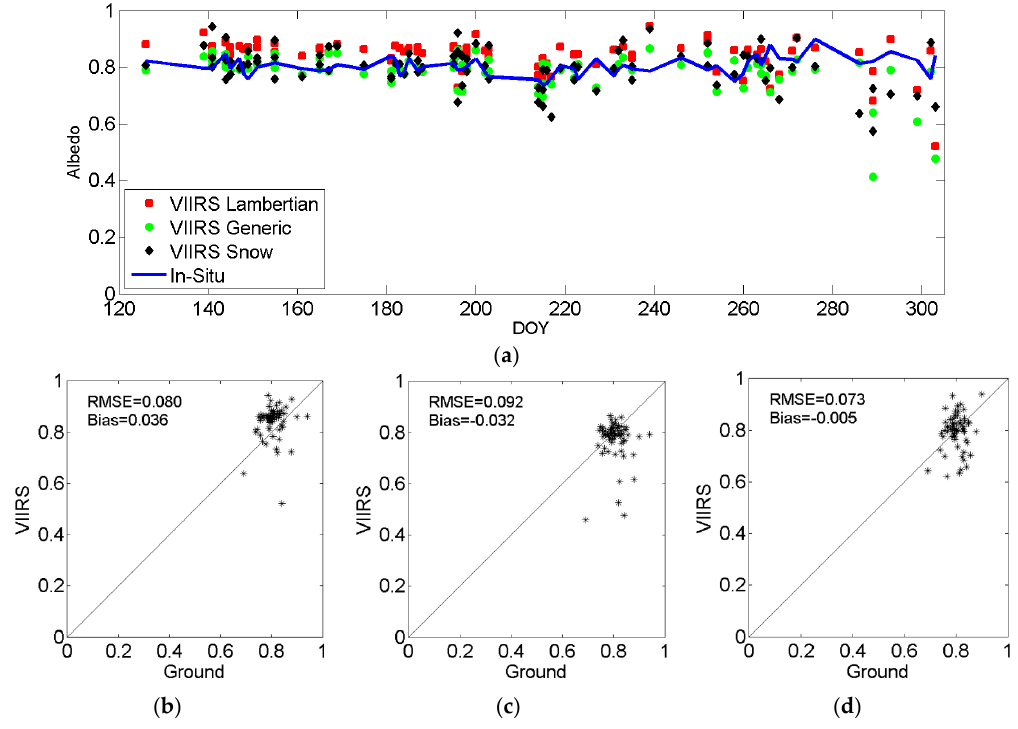
Figure 3. Validation results over a snow-covered site (Saddle) for the year 2013. ( a ) Time series of VIIRS-retrieved albedo using Lambertian LUT, generic BRDF LUT, and snow-specific BRDF LUT; Comparison results between ground truth and VIIRS-retrieved albedo using ( b ) Lambertian LUT; ( c ) generic BRDF LUT; and ( d ) snow-specific BRDF LUT, respectively.